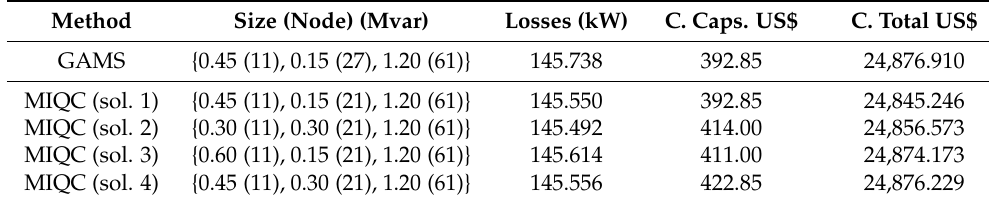
Table 6. Optimal location, sizes, and annual expected costs for the IEEE 69-bus system under peak load conditions.